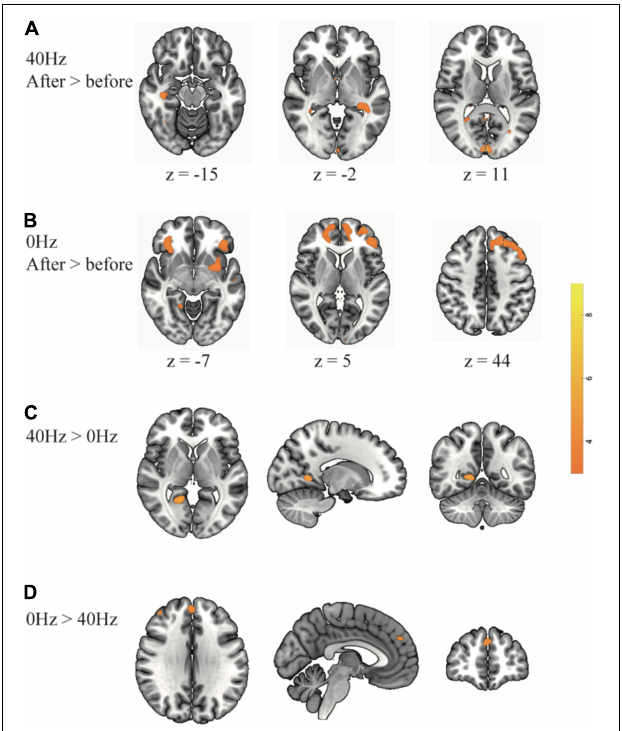
FIGURE 4 | (A) There is a significant interaction of before and after stimulation × light condition in the inferior parietal cortex and thalamus/hypothalamus. (B) Overlay of group differences in enhanced brain activity to frequency: the 40-Hz group is in yellow, and the 0-Hz group is in